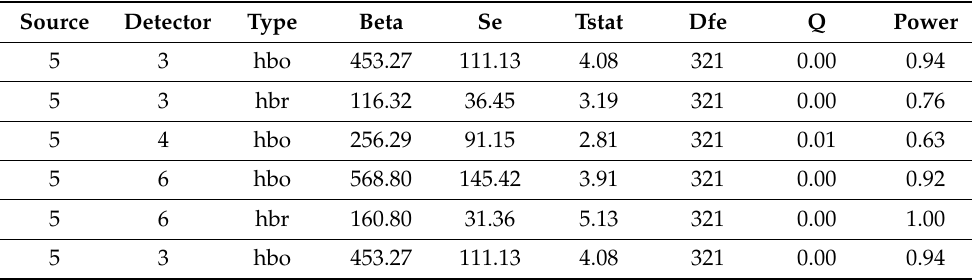
Table A6. t -test statistics for each channel (source–detector pair). Head to Knee Pose B, sit on right heel–Extended Hand to Right Big Toe Hold.